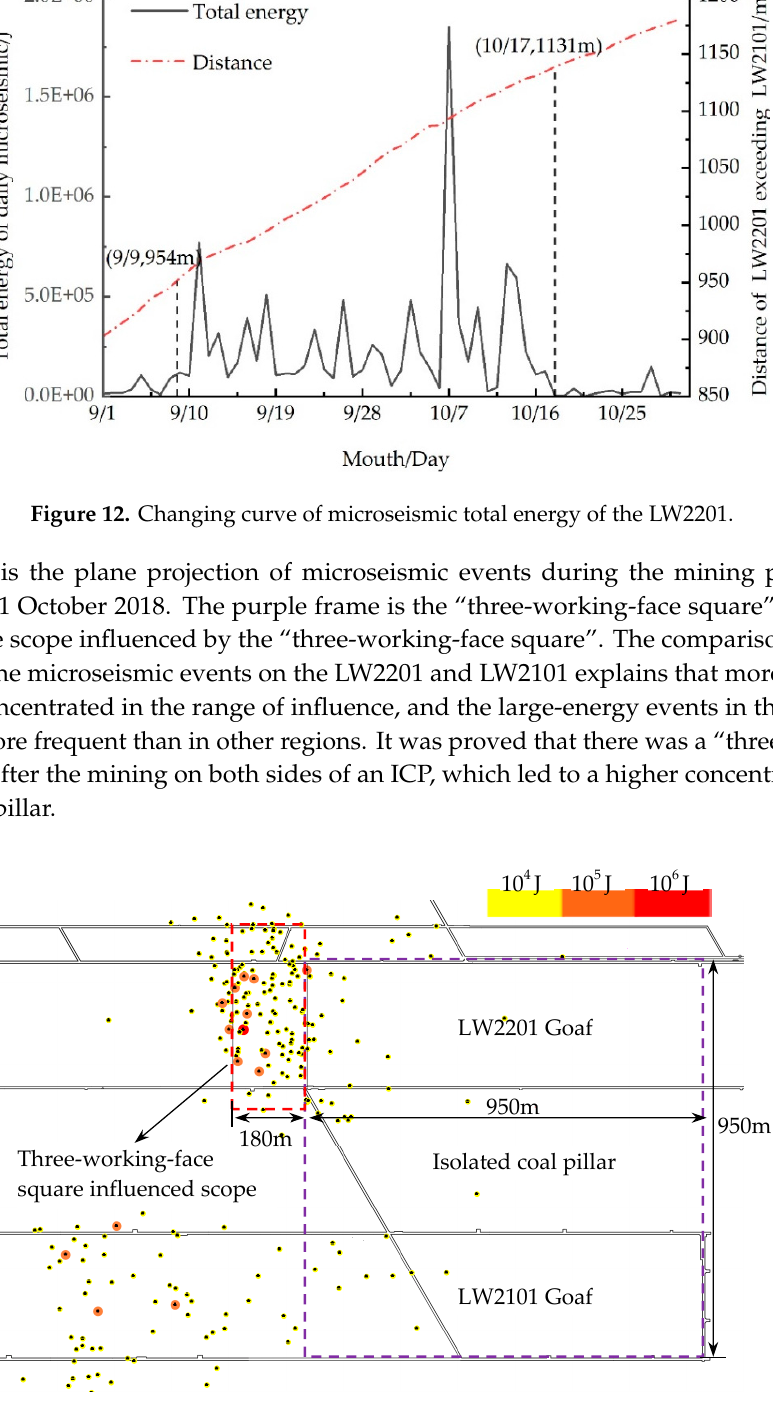
Figure 13. Plane projection of 9.1–10.31 microseismic events.